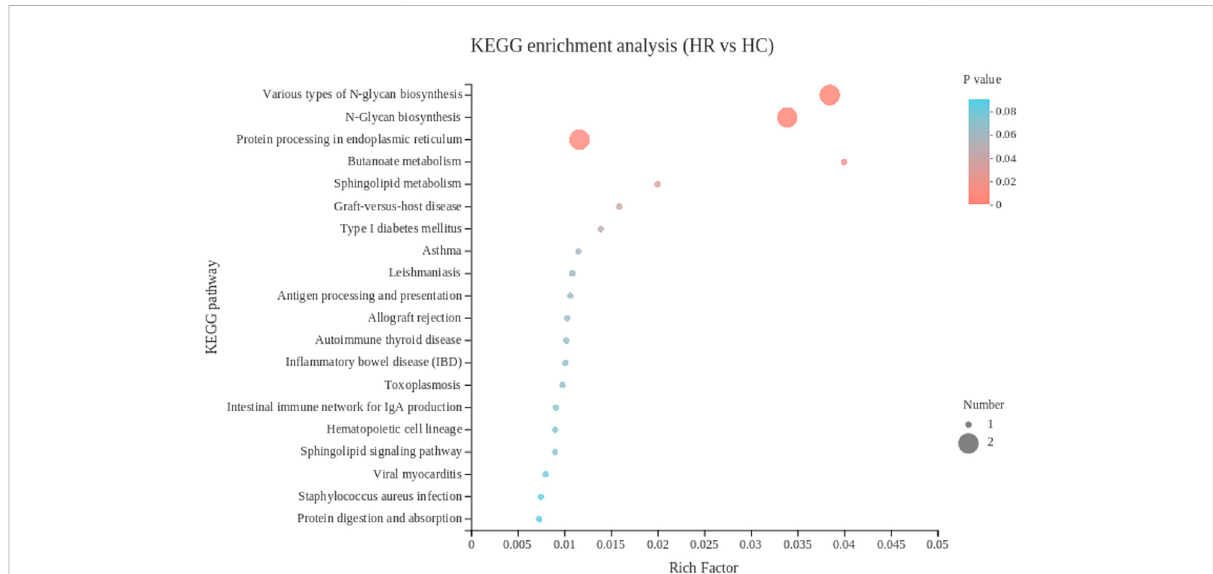
FIGURE 6 Thetop20KyotoEncyclopediaofGenesandGenomespathwaysofDEGsinhypothalamus.Thecolorofthedotrepresentsthe p value,andthe size of the dot represents the number of SDEGs enriched in the reference pathway. HR, hypothalamus of rooster; HC, hypothalamus of capon.